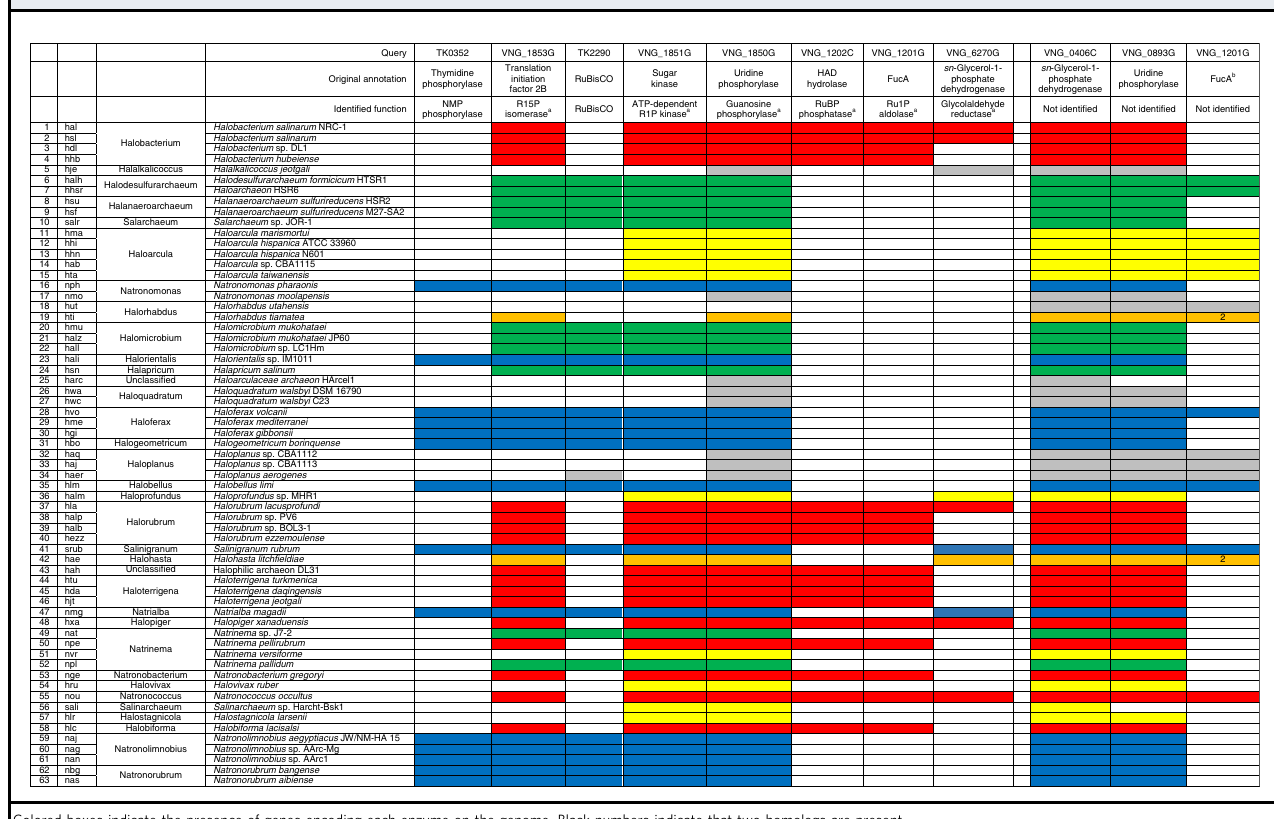
Table 1 Distribution of nucleoside/NMP metabolic genes in halophilic